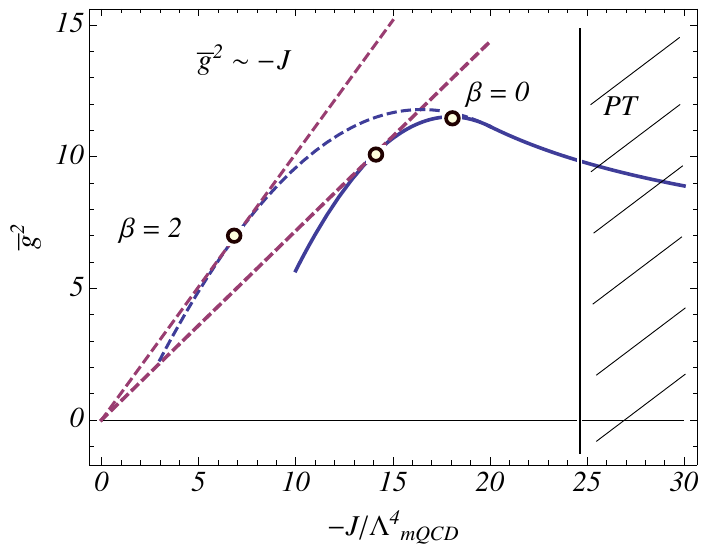
Figure 1. An example of the non-perturbative mirror Quantum Chromo Dynamics (mQCD) coupling constant ¯ g 2 = ¯ g 2 ( J ) behavior as a function of J in consistency with the non-perturbative solution found in Equation